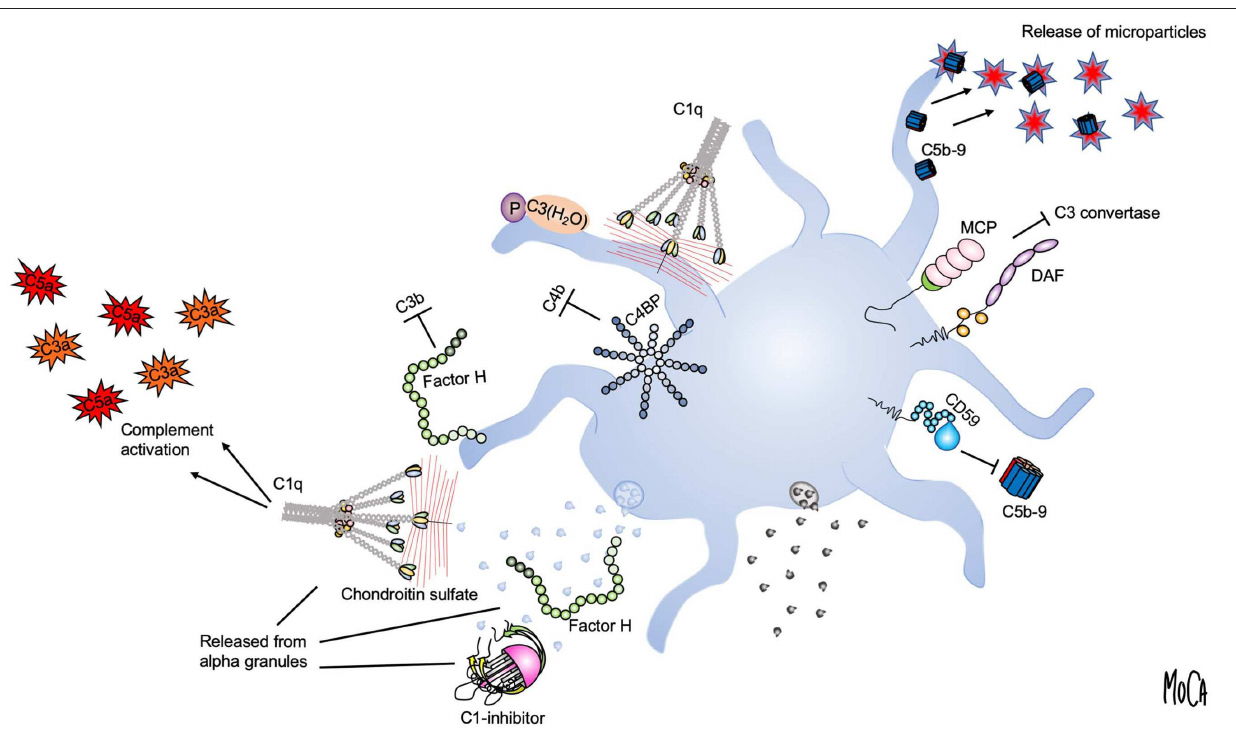
FIGURE 2 | Platelet-complement interactions. Interactions between complement components and activated platelets are shown. The platelet surface provides a binding scaffold for complement factors and supports contact activation of C3 to C3(H 2 O), which interacts with platelet-bound properdin (P) (upper left). C1q recognizes chondroitin sulfate released from activated platelets or bound to the platelet surface and triggers complement activation in the fluid phase (left). Localized formation and surface attachment of sublytic concentrations of C5b9 complexes triggers rapid shedding of pro-coagulant microparticles (upper right). Platelet integrity is maintained by membrane-bound (MCP, DAF, CD59) (right) or fluid-phase complement regulators (C1-inhibitor, factor H, and C4-binding protein (C4BP) (left). C1-inhibitor and factor H are also released from alpha granules (lower